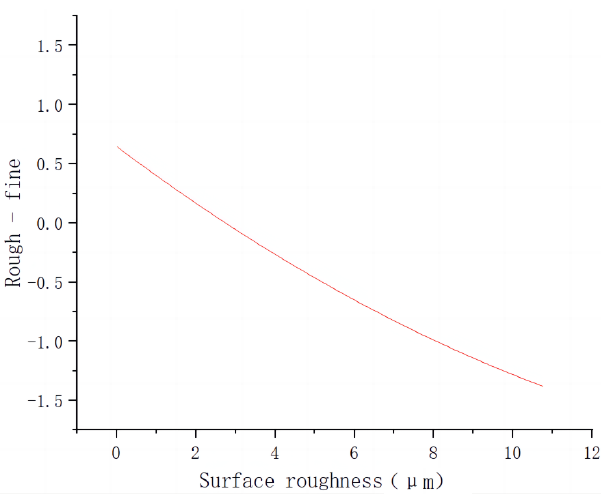
Figure 12. “Rough—Fine” and Surface roughness polynomial fitting function.